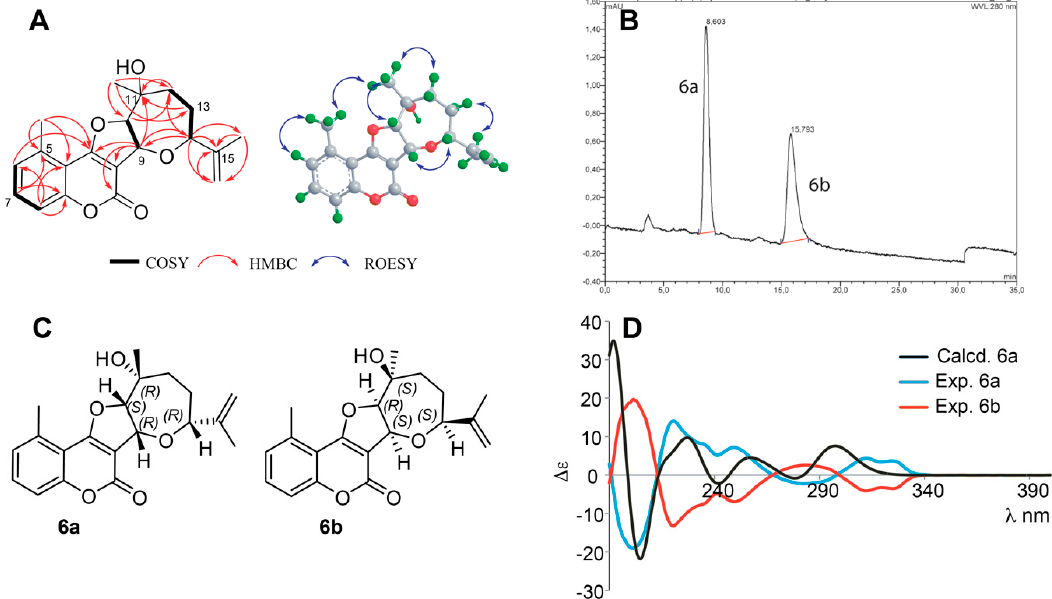
Figure 5. ( A ): Key 2D NMR correlations of 6 . ( B ): Chiral separation of 6 showing two enantiomers in a Figure 5. A : Key 2D NMR correlations of 6 . B : Chiral separation of 6 showing two enantiomers in a 1:1 ratio. ( C ): structures of 6a and 6b with the absolute configuration of stereocenters. ( D ): Calculated 1:1 ratio. C : structures of 6a and 6b with the absolute configuration of stereocenters. D : Calculated ECD spectrum of 6a and experimental ECD spectra of 6a and 6b ECD spectrum of 6a and experimental ECD spectra of 6a and 6b .